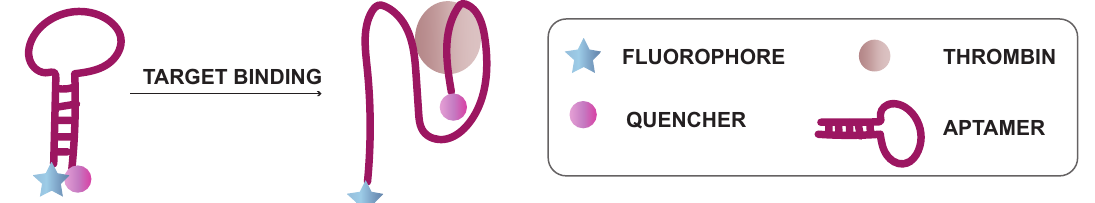
Figure 13. Principle of the anti-thrombin binding aptamer as molecular